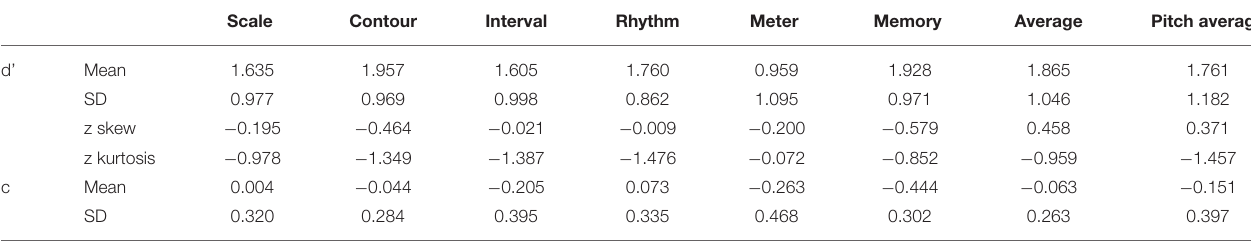
TABLE 3 | Mean and SD of d’ and c measured by signal detection theory. Scale Contour Interval Rhythm Meter Memory Average Pitch average